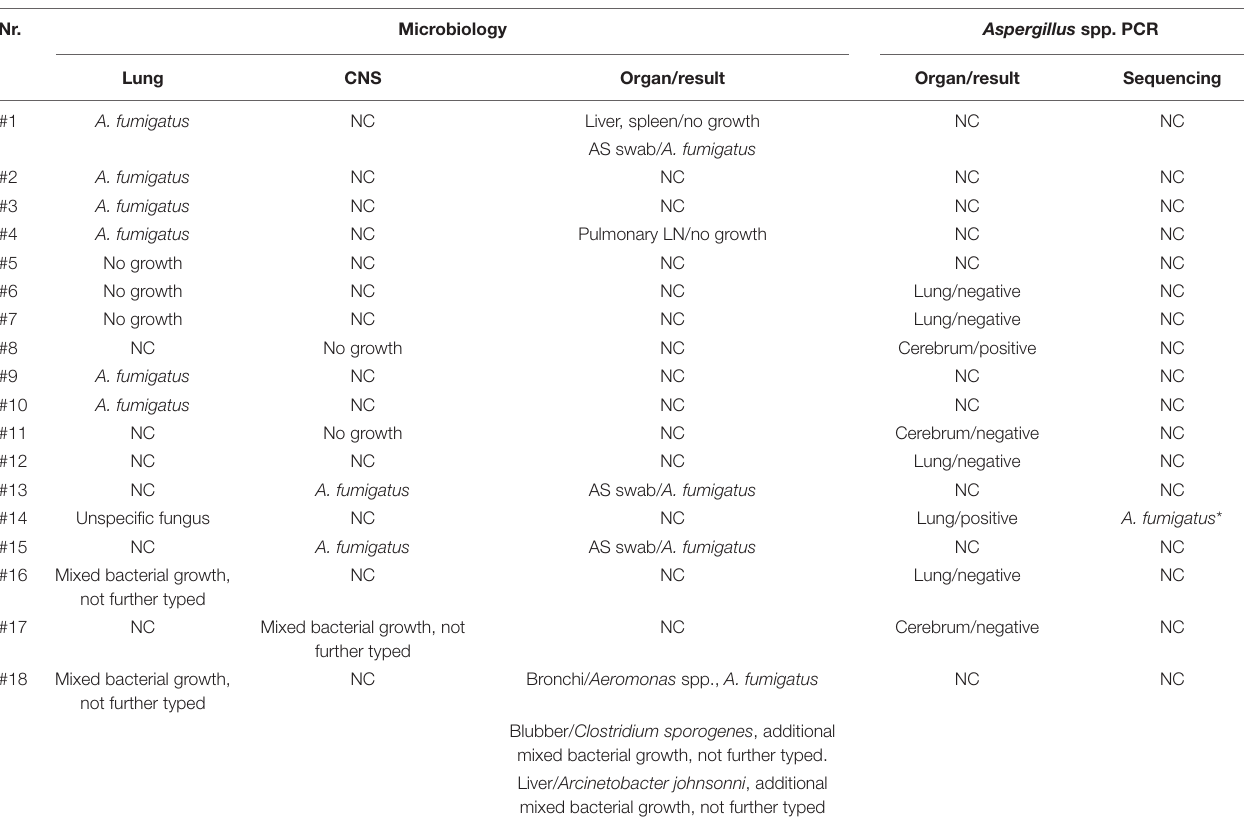
TABLE 4 | Overview of microbiology and PCR results.